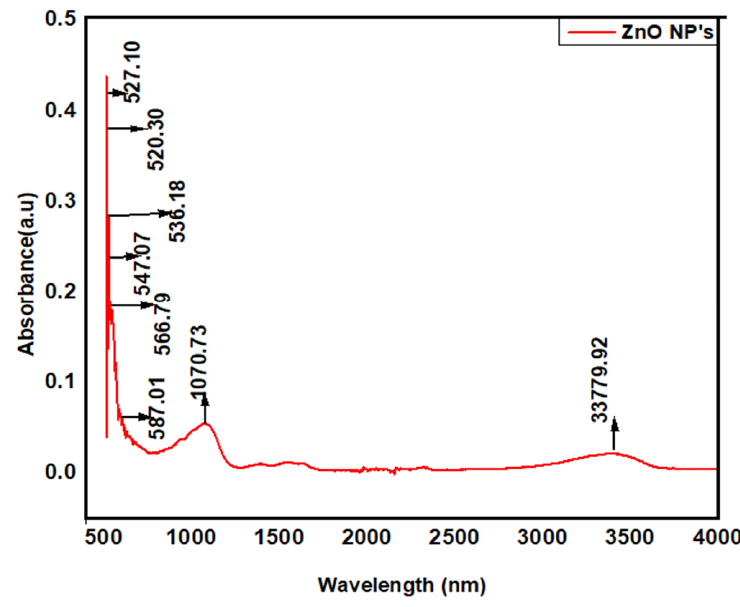
Figure 4. FTIR spectrum of ZnO NPs.